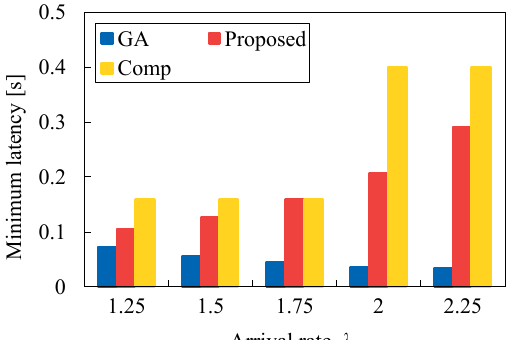
Figure 14. Minimum latency for each method versus λ in the case of N 1 = 50 and τ = 0.2.